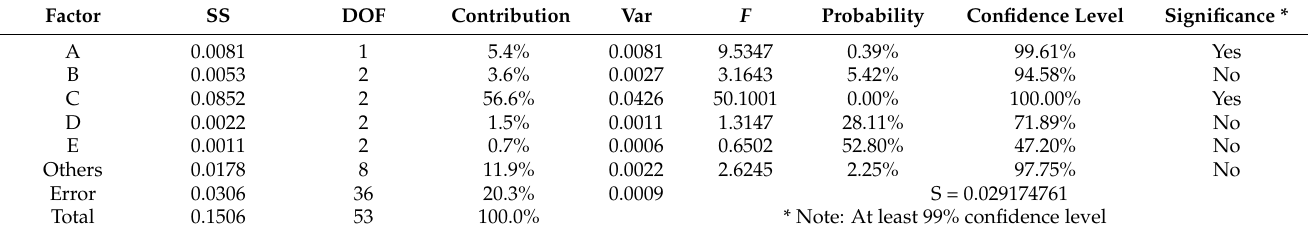
Table 4. Each factor’s confidence level was related to the sonography scan protocol effectiveness. Confidence levels exceeding 99% prove the factor’s significance.